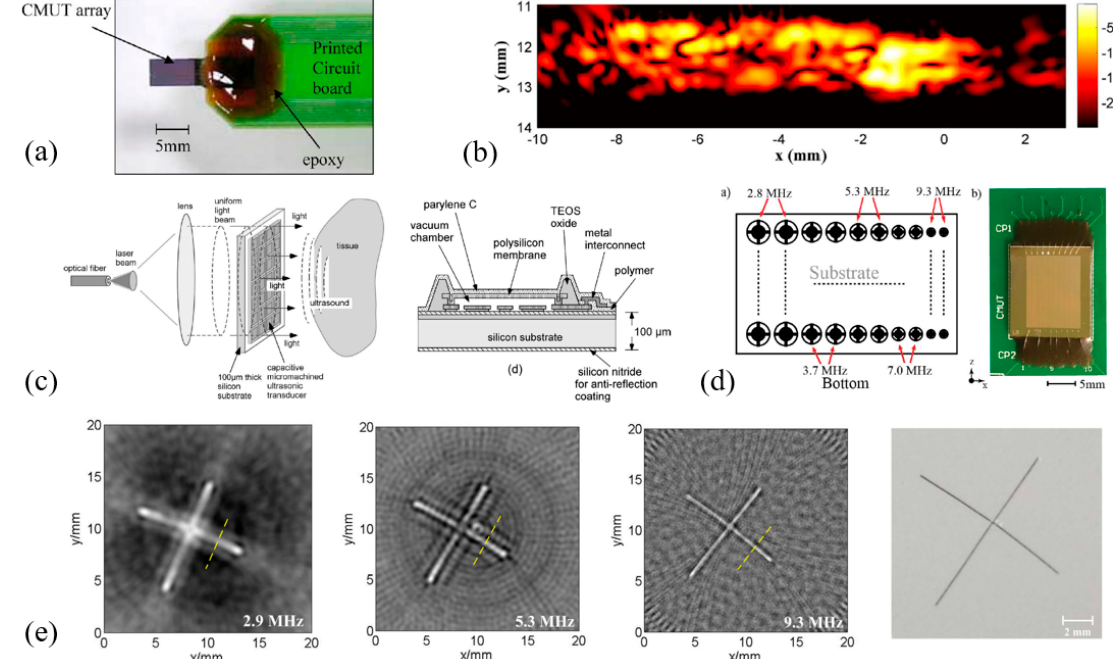
Figure 28. ( a ) Photograph of a 2D cMUT array wire bonded on a PCB (Reproduced with